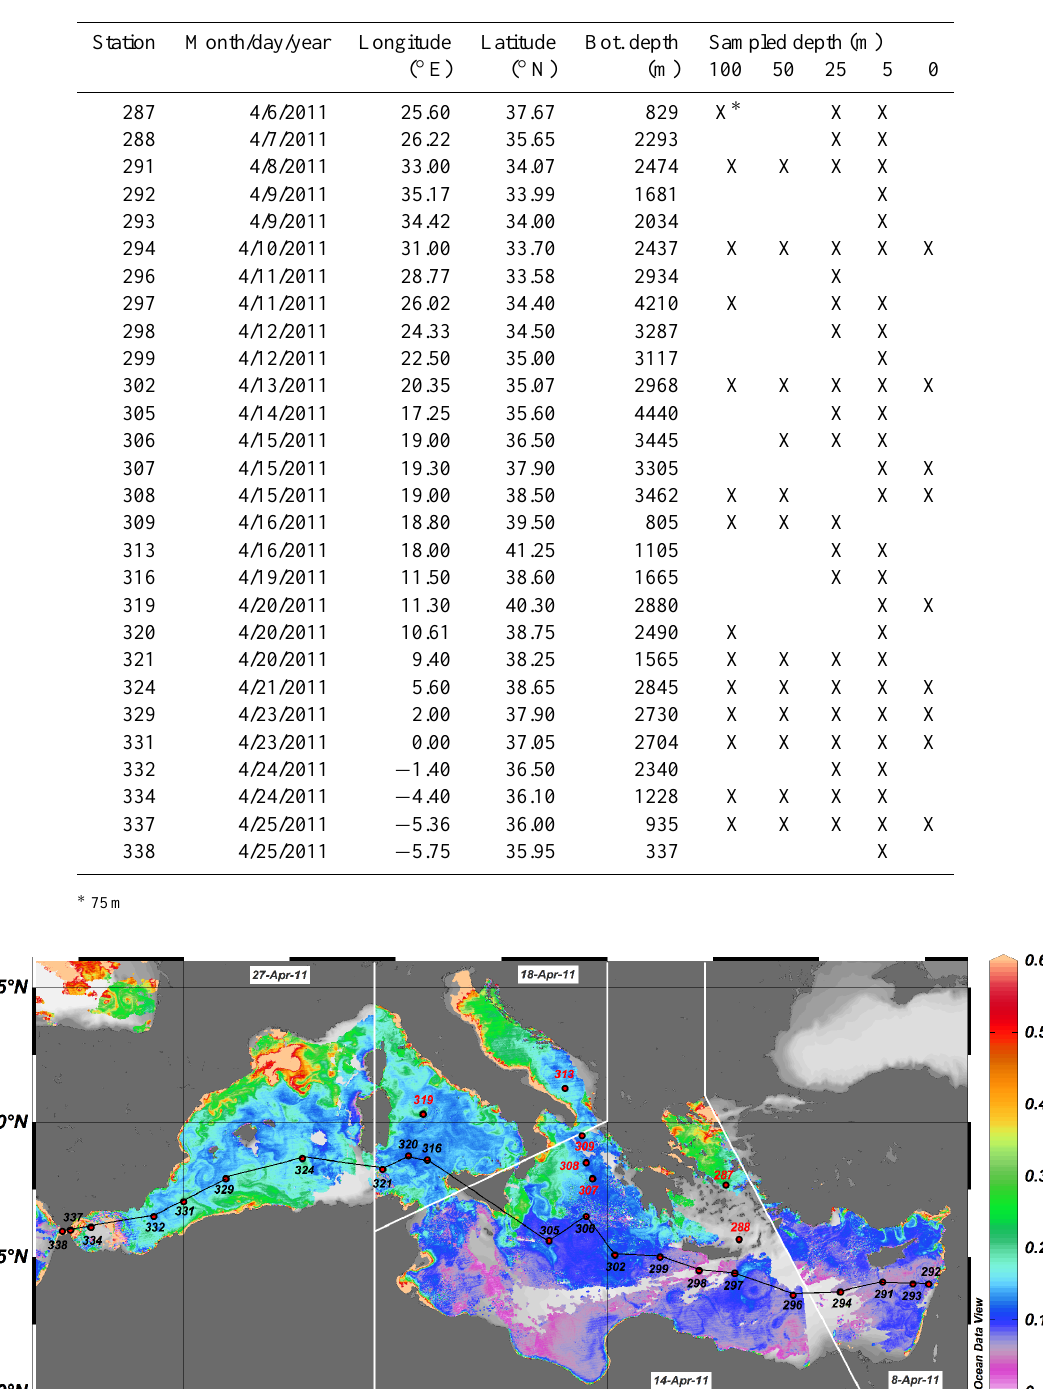
Table 1. Location, date, and water depth from which the samples were collected.